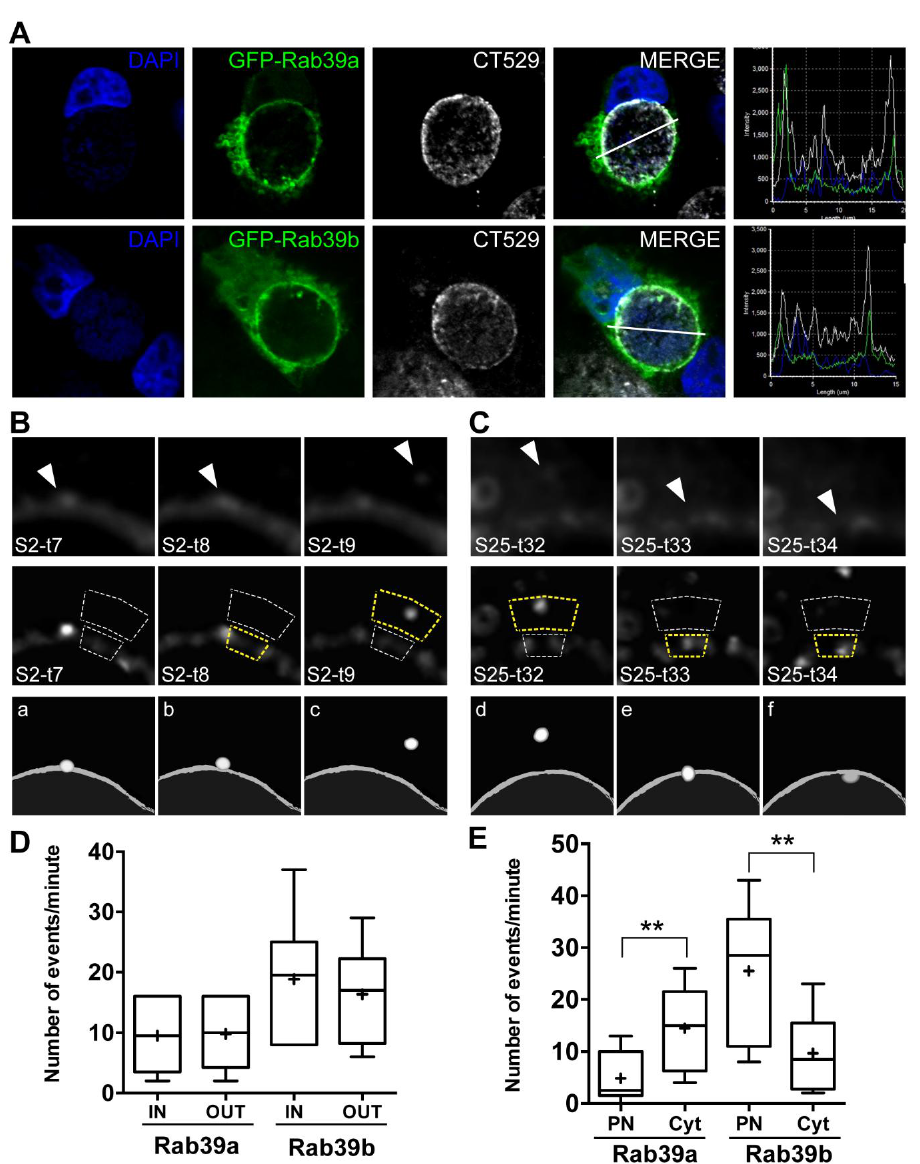
Figure 4. Analysis of the interaction of Rab39a- or Rab39b-labeled vesicles with chlamydial inclusions. HeLa cells overexpressing GFP-Rab39a or GFP-Rab39b were infected with CT (MOI 1) for 24h. ( A ) Rab 39a ( top ) and Rab39b ( bottom ) are shown in green. Bacterial protein CT529 was detected by immunofluorescence (white). DNA was labeled with DAPI (blue). Intensity profiles show Rab39 (green) and CT529 (white) labels across the line that traverses the inclusion ( right ). ( B , C ) Images were taken by spinning disk microscopy every 1 s during 60 s: ( top ) sections (S) of the chlamydial inclusion membrane at the indicated times (t); ( middle ) previous images with an enhanced intensity signal of moving object, where dotted line polygons indicate regions of interest (ROIs) and yellow ROIs indicate a peak of intensity; and ( bottom ) schematic representations of previous images that correspond to the departure (a–c) or arrival (d–f) of vesicles to the surroundings of the chlamydial inclusion, respectively. ( D ) Quantification of Rab39-labeled vesicles that reach and leave the chlamydial inclusion area per minute in each confocal plane. ( E ) Inclusions were split into two halves: the perinuclear side (PN) and at the opposite side called cytosol (Cyt). The amount of events that occurred per minute was quantified in both regions. Data correspond to the analysis of chlamydial inclusions from six independent experiments for each Rab39 isoform. Central lines represent medians and crosses depict the means (Bootstrap test, ** p <